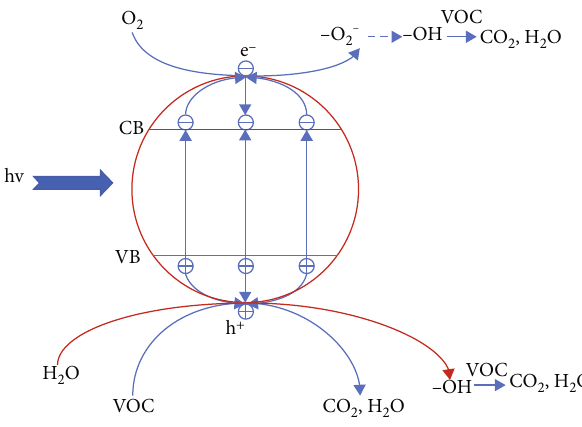
Figure 2: Photocatalytic mechanism of TiO